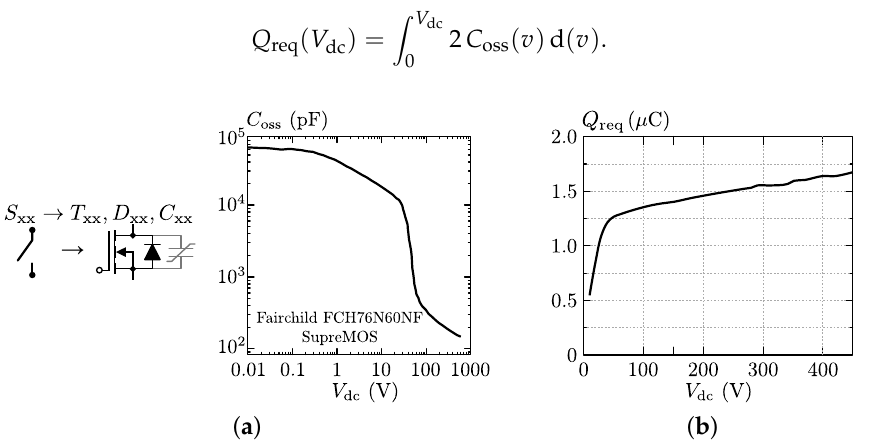
Figure 5. ( a ) Characteristic of the non-linear parasitic output capacitance of the used FAIRCHILD FCH76N60NF MOSFETs ; ( b ) Charge required to charge/discharge the MOSFET’s non-linear parasitic output capacitance C oss from 0 V to V dc (or vice versa) during commutation of a bridge